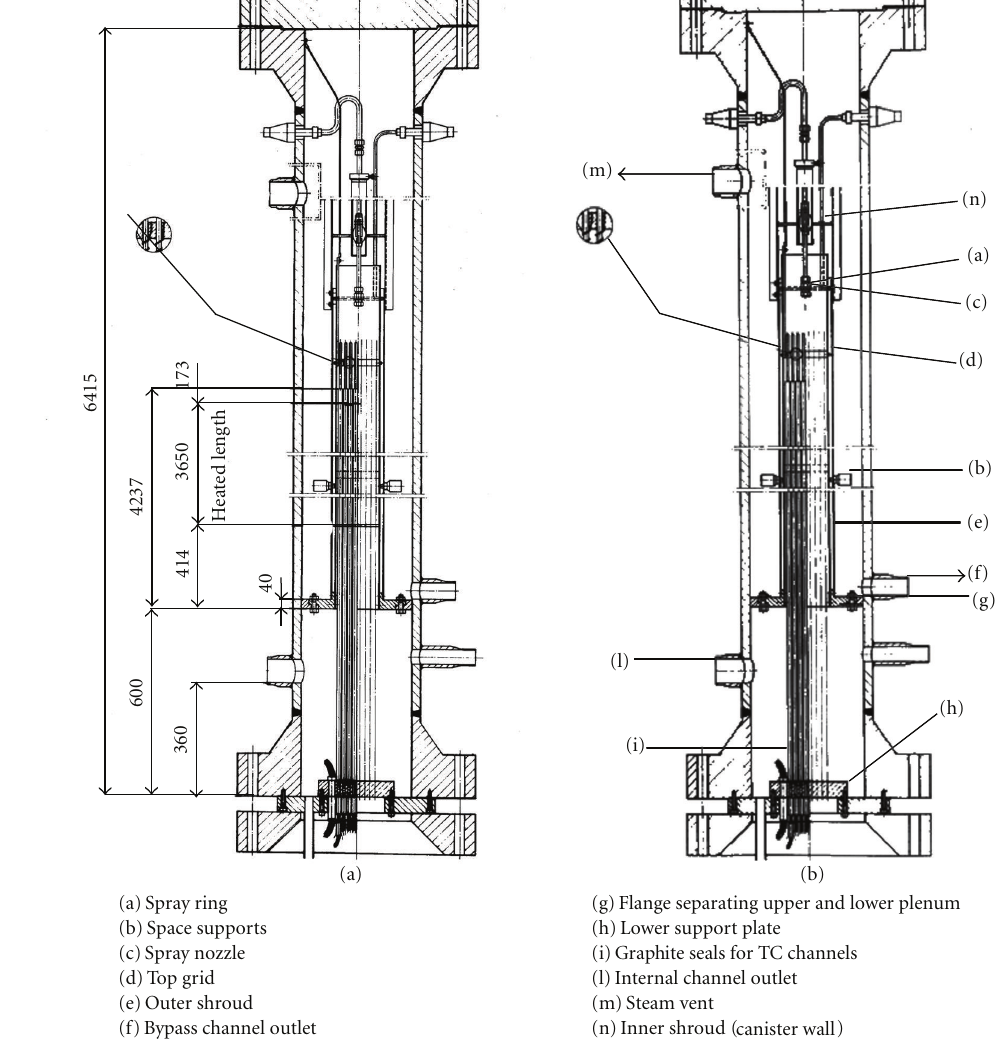
Figure 2: Section of the test